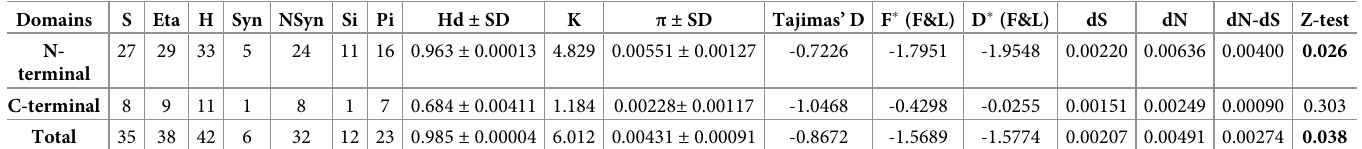
Table 1. DNA sequence polymorphism analysis and neutrality test of Iranian pvrbp2b sequences in N-terminal (nt: 502–1377) and C-terminal (nt: 1378–1896) domains estimated by DnaSP and MEGA6 software (current study, n = 60). Domains S Eta H Syn NSyn Si Pi